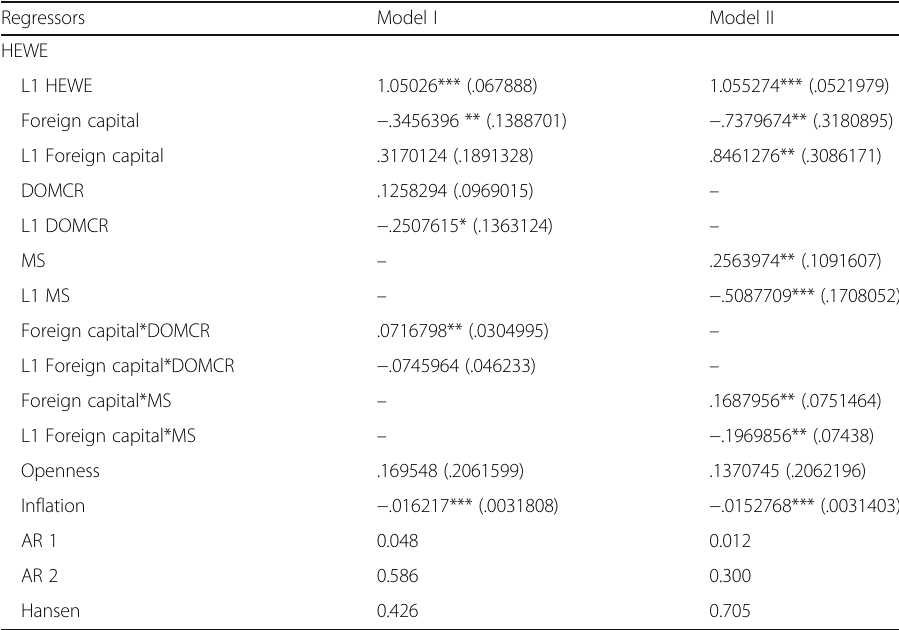
Table 16 Dynamic panel data estimation, one-step system GMM: interaction effect of Foreign Cap- ital Inflows and financial development on Economic Welfare Enhancement (HEWE)